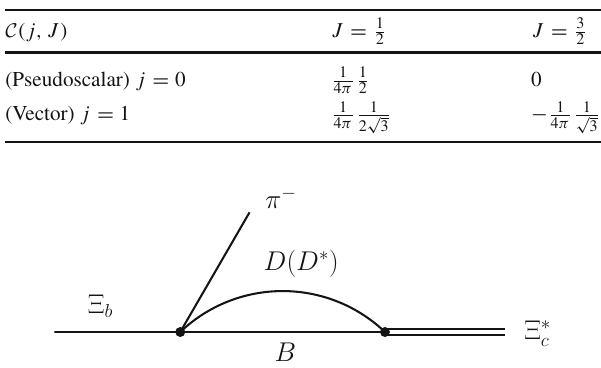
Fig. 3 Mechanism for the production of the (cid:2) ∗ c resonances by re- scattering of D ( D ∗ )(cid:5) ((cid:6)) and coupling of the meson–baryon com- ponents to (cid:2) ∗